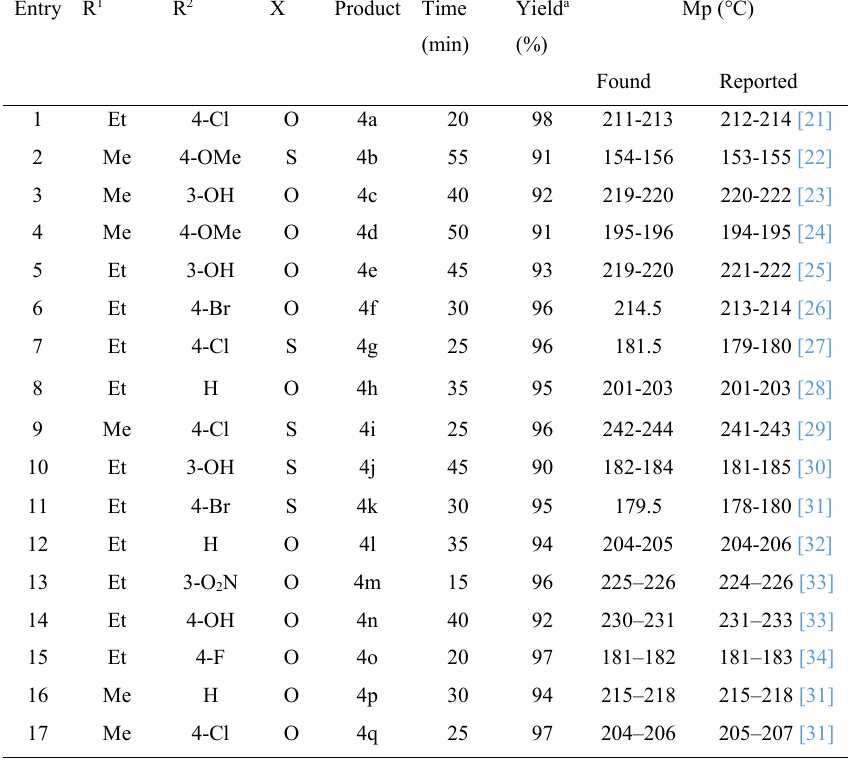
Table 2. Synthesis of DHPMs (4a-l) by using CuFe 2 O 4 @PEO-SO 3 H nanocatalyst.